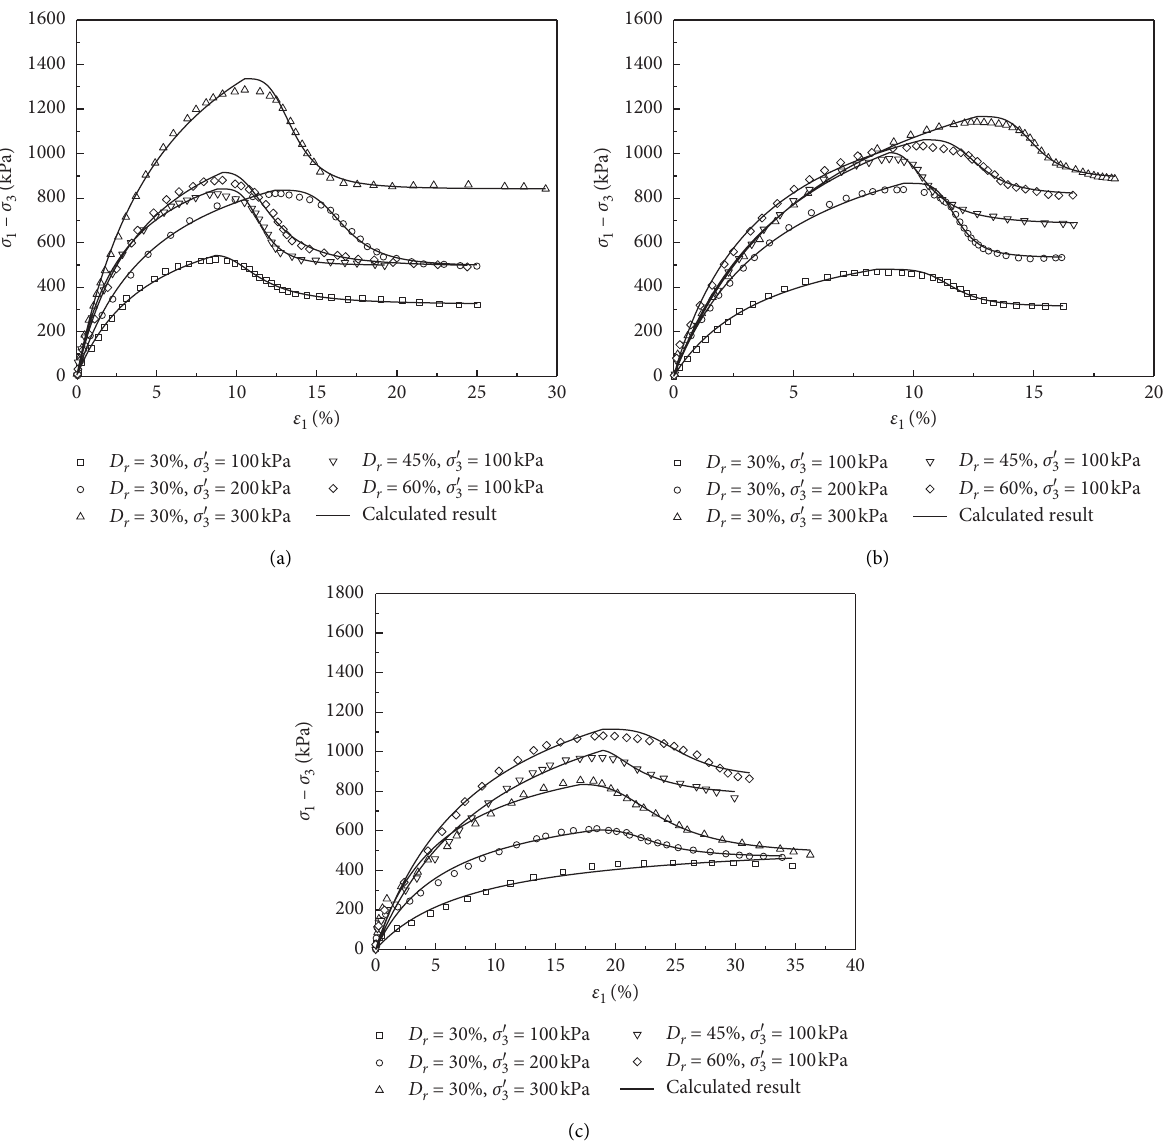
Figure 13: Comparison between test data and calculated results. (a) Dry calcareous sand. Saturated calcareous sand at (b) drained compression and (c) undrained